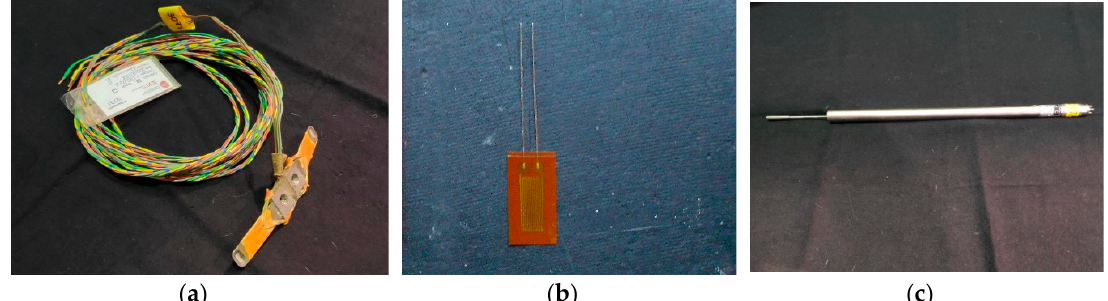
Figure 1. Classical instrumentation of masonry specimens: ( a ) unidimensional deformeter; ( b ) electrical strain gauge; ( c ) linear variable displacement transformer (LVDT) sensor.